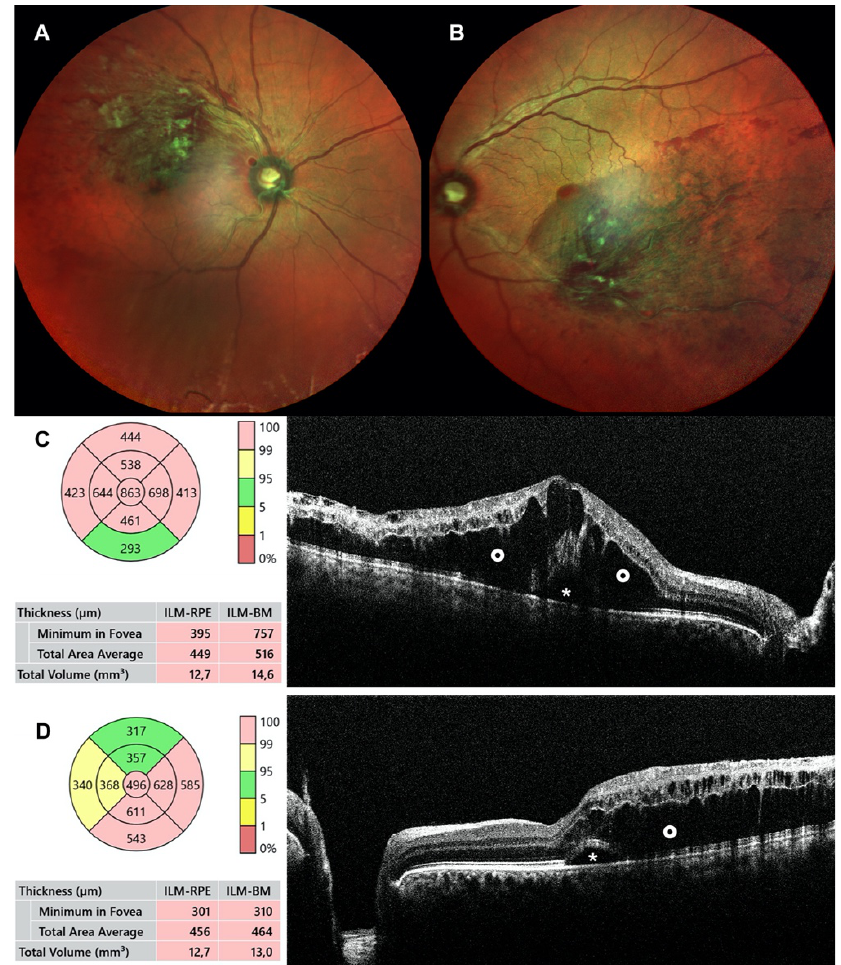
Figure 1. Baseline posterior pole multicolor image and optical coherence tomography of both eyes: ( top ) Fundus photographs showing widespread hemorrhages and axonal congestion upstream of the venous occlusion of superotemporal branch vein in the right eye ( A ) and inferotemporal branch vein in the left eye ( B ); (bottom) OCT macula (Macula 3D mode) shows a significant cystoid macular edema and intraretinal fluid (O), associated with subfoveal neuroretinal detachment (*) in both eyes, with a central macular thickness of 863 μm for the right eye ( C ) and 496 μm for the left eye ( D ).